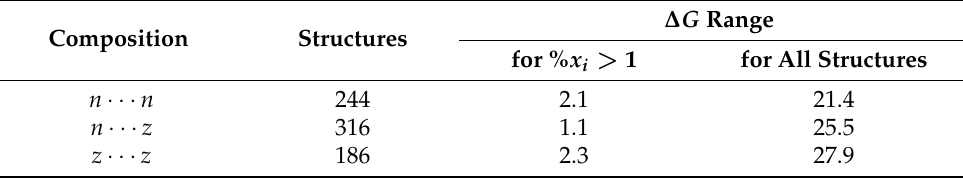
Table 2. Summary of structural and energetical properties of the cysteine dimers. ∆ G range: Gibbs en- ergy difference between the highest and lowest energy structure in kcal/mol. % x i : isomer populations listed in Tables S1–S3 in the Supplementary